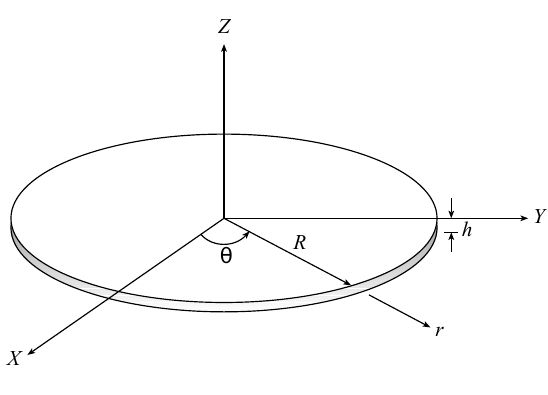
Fig. 1. Geometry of a circular